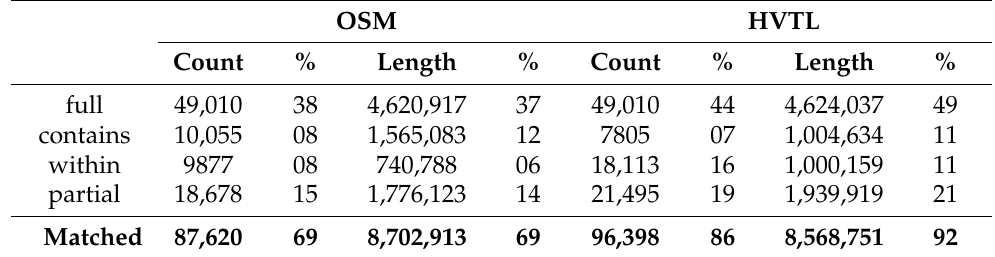
Table 2. Number and length (meters) of segments matched between OSM and HVTL datasets. OSM